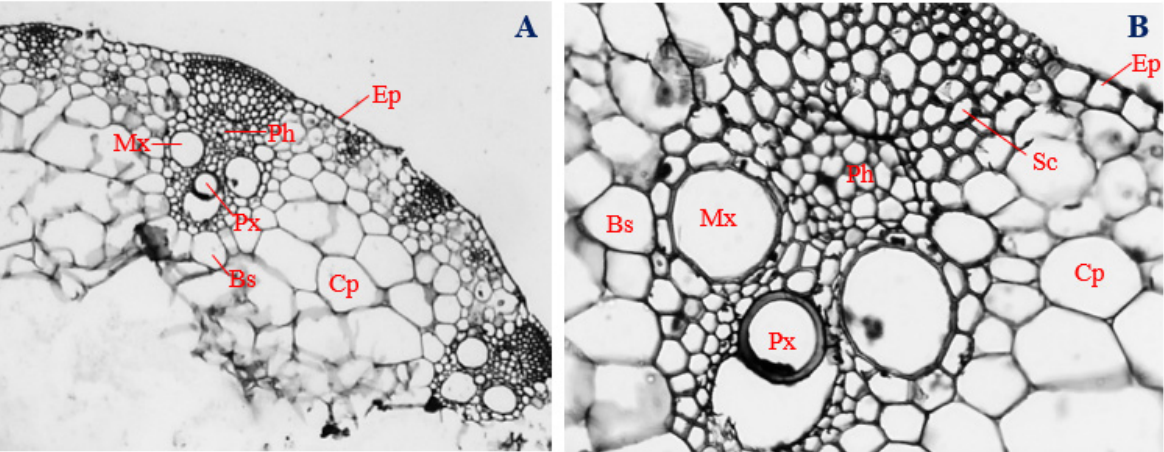
Figure 5. The transverse section of an uninoculated corn stem. ( A ) Magnification 200×; ( B ) magnifi- cation 400×. Ep, epidermis; Cp, cortical parenchyma; Sc, sclerenchyma; Ph, phloem; Mx, metaxylem; Px, protoxylem; and Bs, bundle sheath.